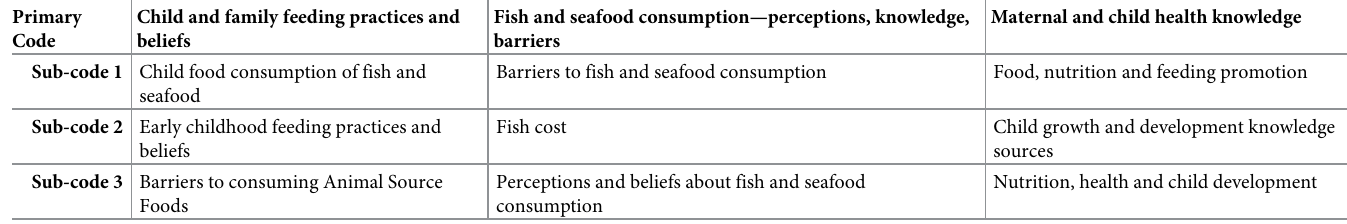
Table 1. Example of primary and sub-codes. Primary